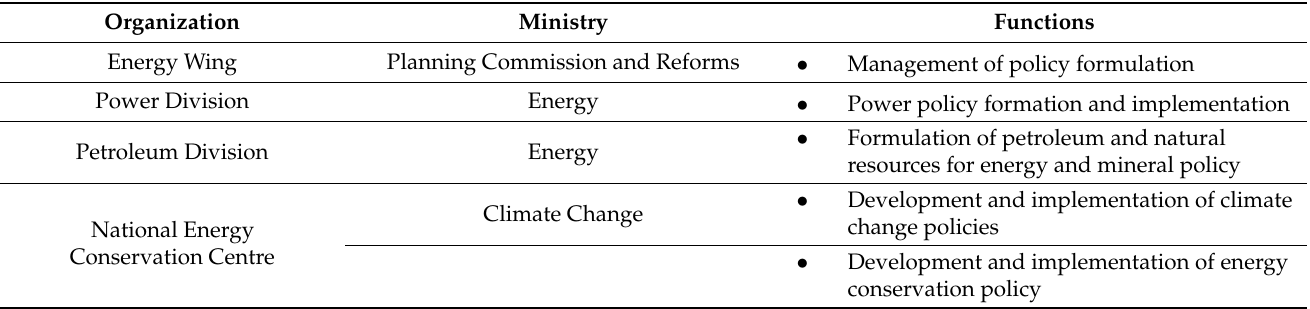
Table 3. Key energy sector organizations